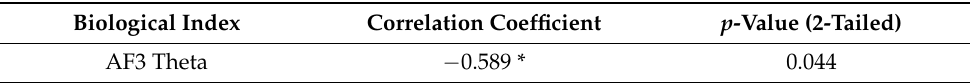
Table 14. Correlation coefficients between the number of errors in Task2 and the mean values of biological indexes during Task2 (during-error condition) (* correlation is significant at the 0.05